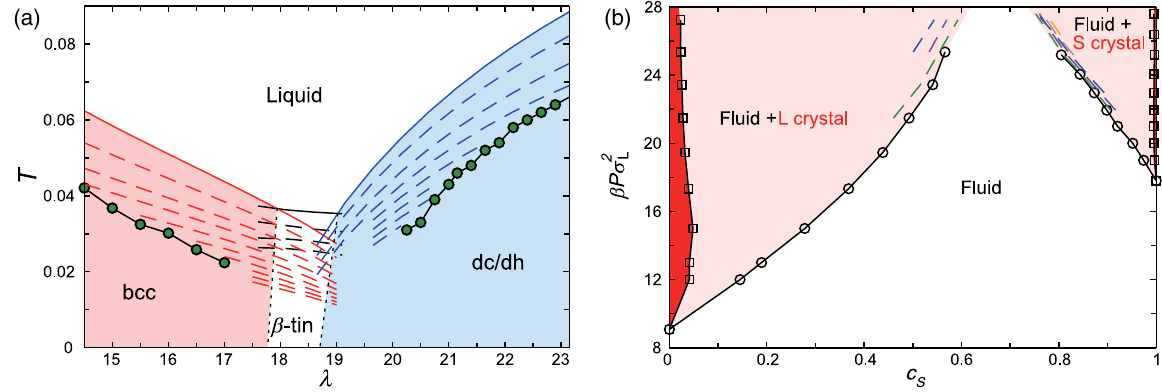
FIG. 1. Phase diagrams and thermodynamic driving force. (a) P ¼ 0 phase diagram of the SW model. The different colors indicate the regions of stability of the crystalline phases: bcc (red) for small λ , β -tin (white) for intermediate λ , and dc (blue) for high λ . Continuous lines represent the melting line of the crystalline phases. Dashed lines are lines where β Δ μ ¼ k ; with the increments in k being Δ k ¼ 0 . 2 between each line (starting from the melting line where k ¼ 0 ). Dots represent the homogeneous nucleation line, which here is defined as the state points in which homogeneous nucleation occurs directly in simulations. (b) Phase diagram of the BD model. The dark red regions indicate the L and S hexagonal solids, respectively, at low and high c . The light red regions indicate fluid-solid coexistence, S limited by the liquidus lines (circles) and the solidus lines (squares). The dashed lines represent lines of constant driving force, β Δ μ ¼ k , with k ¼ 0 . 05 , 0.1, 0.15 in the liquid þ L region, and k ¼ 0 . 005 , 0.01, 0.015, 0.02, 0.025 in the liquid þ S